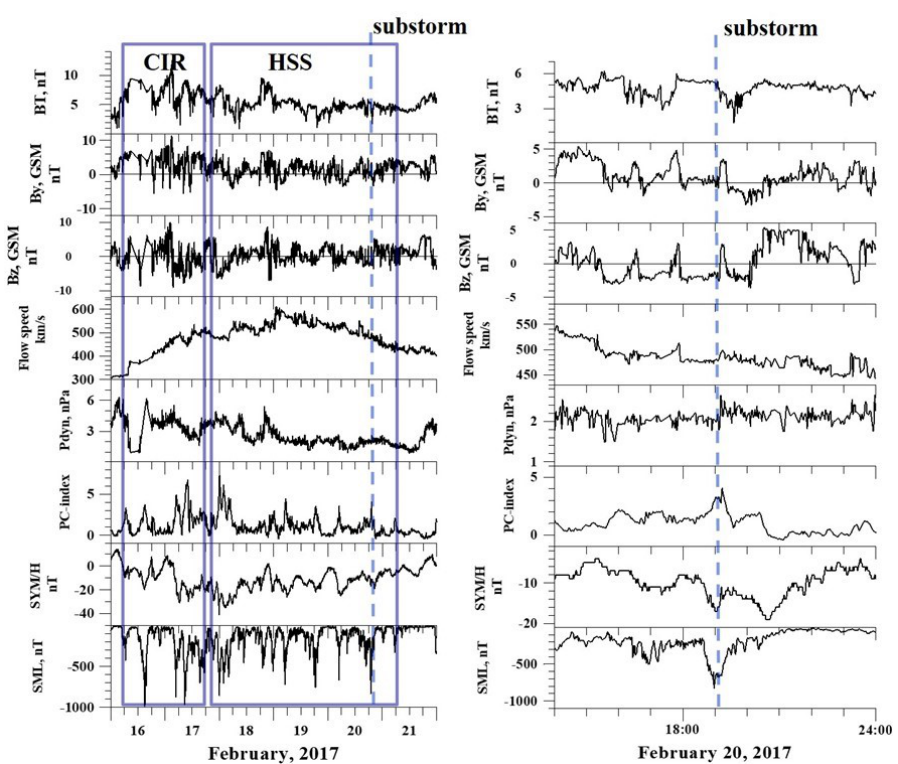
Fig.1. Solar wind and the interplanetary magnetic field components and some geomagnetic indices during the examined event on 20